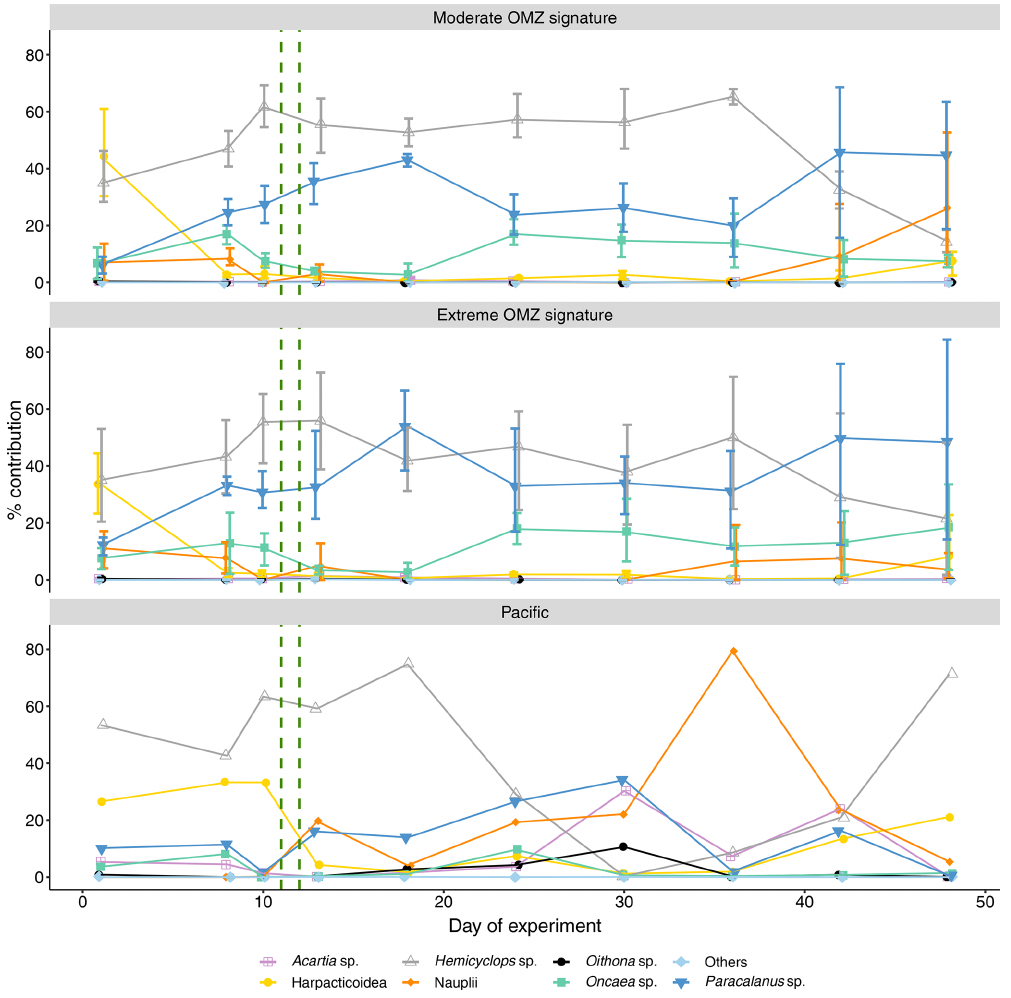
Figure 5. Percent contribution of copepod genera and copepod nauplii to total copepod abundance. Shown is the mean across OMZ treat- ments (moderate and extreme signature mesocosms, respectively) with 95% confidence intervals and the contribution of each category in the Pacific. The category “others” comprises copepods of the genera Calanus , Centropages , Clausocalanus , Corycaeus , Clytemnestra , Eu- calanus , Euterpina , Labidocera , Mecynocera , Microsetella , Scolecithrix , and Temora . The green vertical dashed lines indicate the days of OMZ water